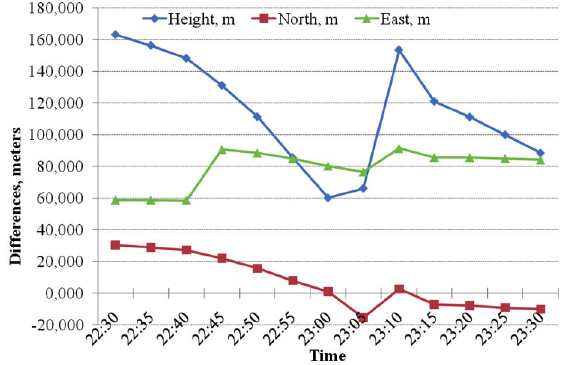
Fig. 2. Values of CPOS station called KRSS in 2003